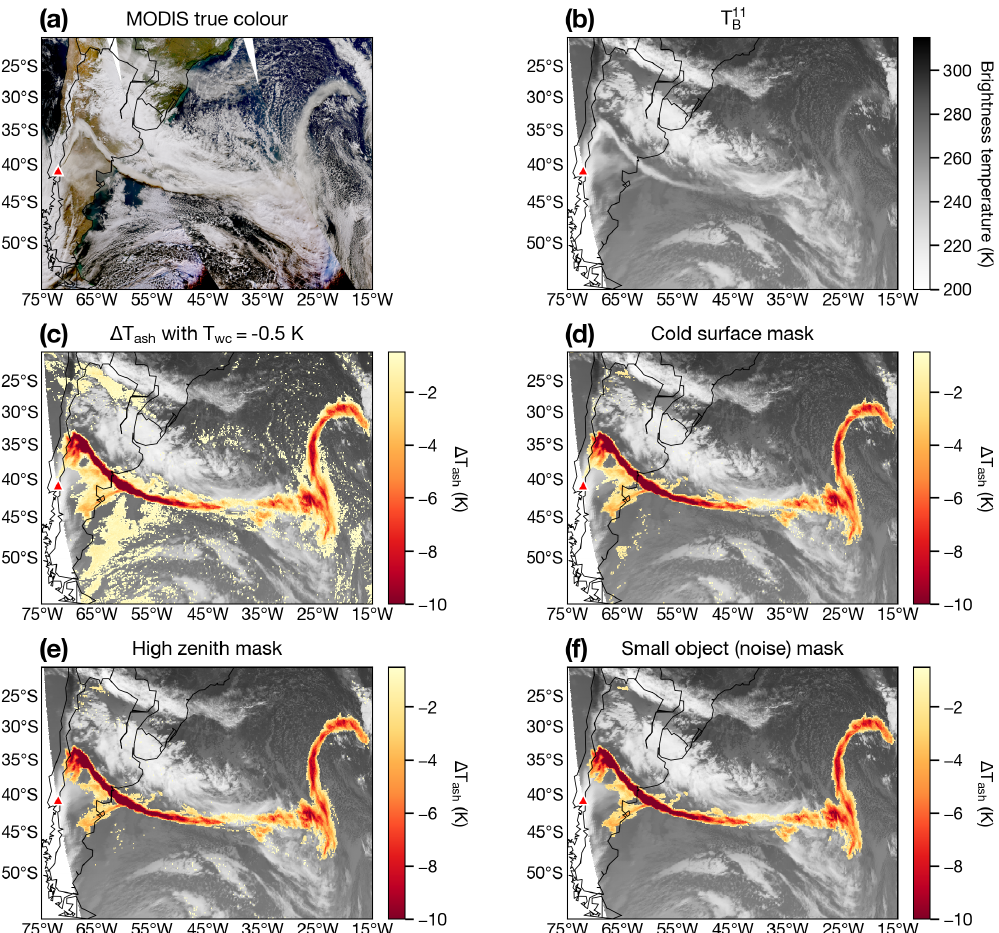
Figure A1. Volcanic ash detection scheme for the Puyehue-Cordón Caulle (indicated by the triangle on each map) eruption. (a) MODIS True Color composite from 6 June 2011 at 15:15–18:40UTC. (b) SEVIRI 10.8µm brightness temperature ( T 11 (c) Same as panel (b) with water-vapour-corrected BTD ( (cid:49)T ash = T 11 surface, high zenith and noise masks applied,